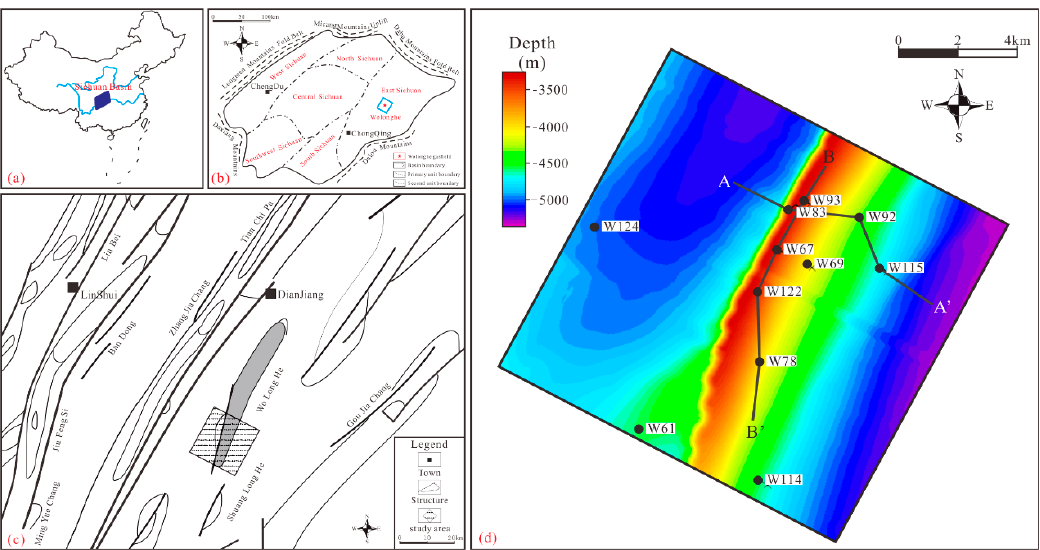
Figure 1. Structural map of the Sichuan Basin and research area. ( a ) The Sichuan Basin is located in western China; ( b ) The Sichuan Basin is divided into six structural units, mainly including Western Sichuan Low Gap Belt, Southwest Sichuan Low Gap Belt, Central Sichuan Flat Gap Belt, North Sichuan Low Gap Belt, South Sichuan Low Gap Belt, East Sichuan Bamian Mountain Blocked Fold Belt; ( c ) The Wolonghe gas field is located in the Wolonghe structure in the eastern part of the Sichuan Basin; ( d ) Buried depth map of Maokou formation.